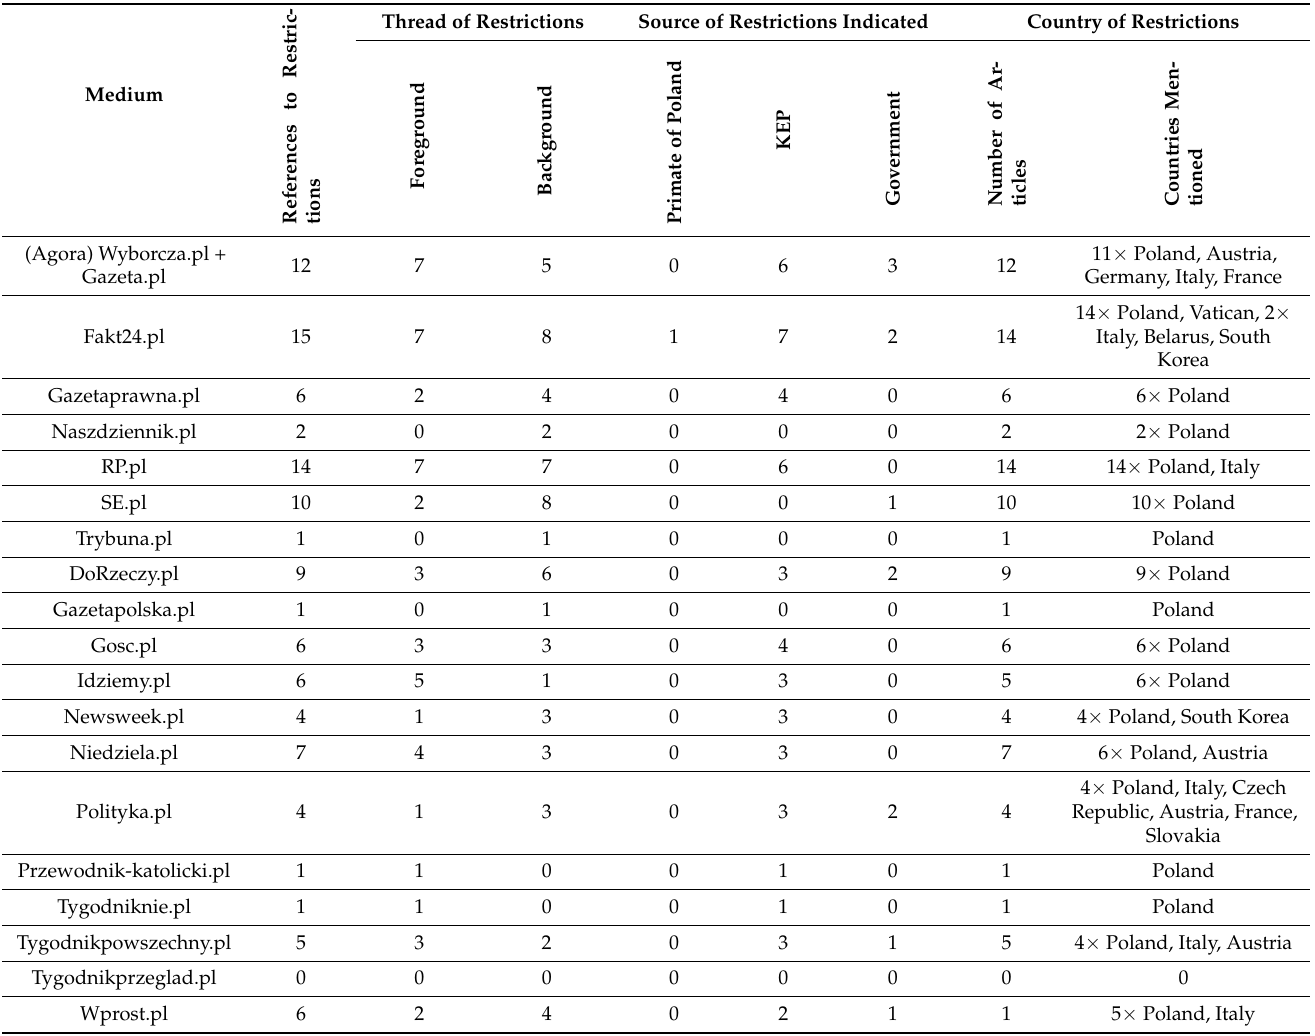
Table 5. Media references to restrictions in religious